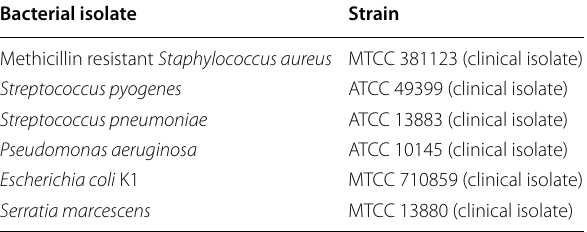
Table 1 Bacterial isolates used in this